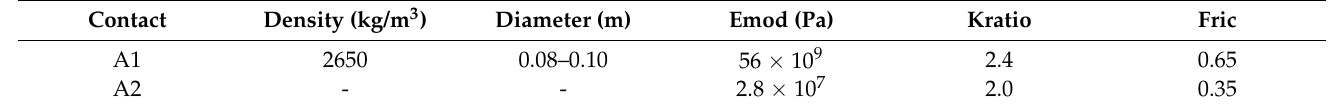
Table 5. Micro-parameters of BFR gabion. Table 5. Micro ‐ parameters of BFR gabion.